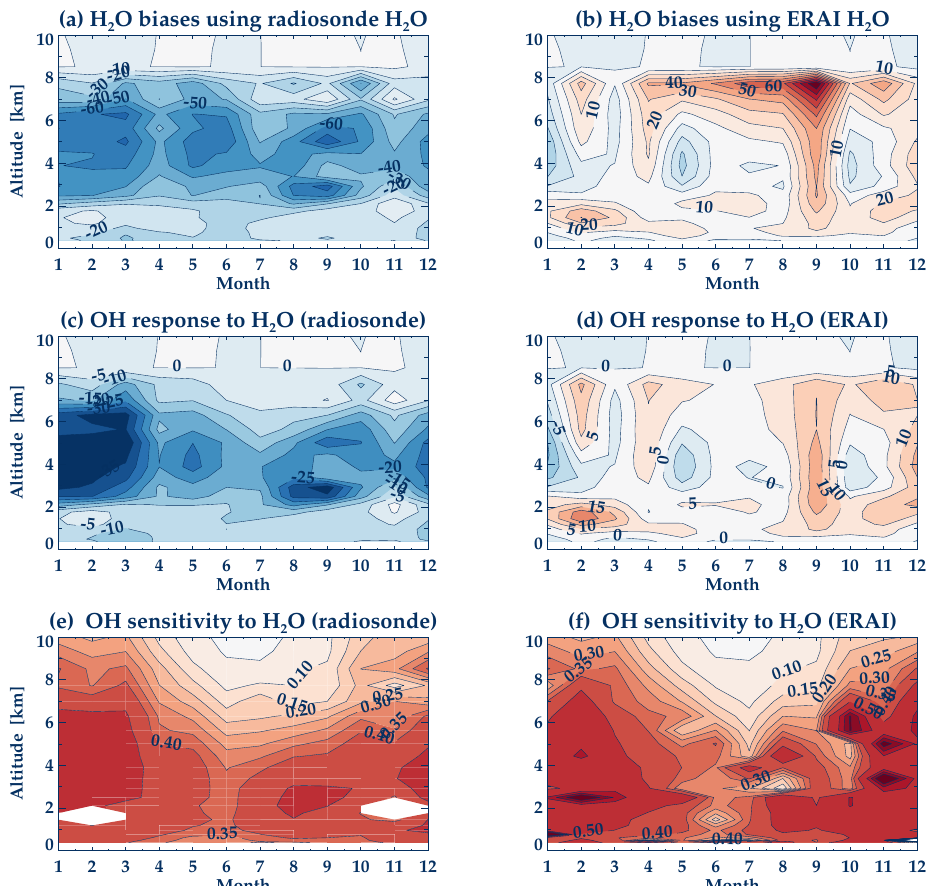
Figure 6. Multi-annual and monthly-mean OH responses to H 2 O between perturbation simulations and the reference simulation. (a) Ra- diosonde – NIWA–UKCA H 2 O (%) relative to the reference simulation. (b) ERAI – NIWA–UKCA H 2 O (%) relative to the reference simulation. (c) OH difference (%) relative to the reference simulation between simulations using radiosonde and NIWA–UKCA H 2 O (a) . (d) OH differences (%) relative to the reference simulation between simulations using ERAI and NIWA–UKCA CCM H 2 O (b) . (e) Ratio of rel- ative OH changes (c) to relative changes in H 2 O (a) . (f) Ratio of relative OH changes (d) to changes in H 2 O (b) . Above 8km NIWA–UKCA H 2 O was used in both cases. Therefore, differences with respect to the reference simulation are close to